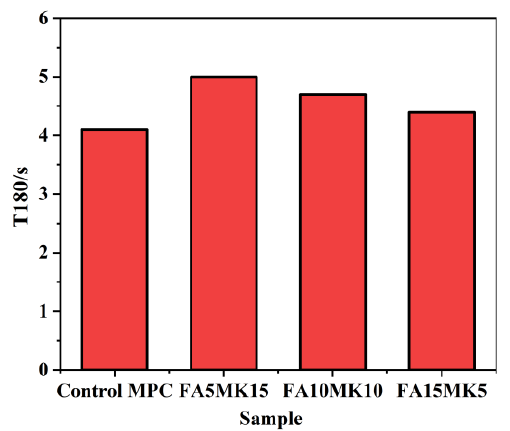
Figure 9. MPC rheological properties with different contents of MK.